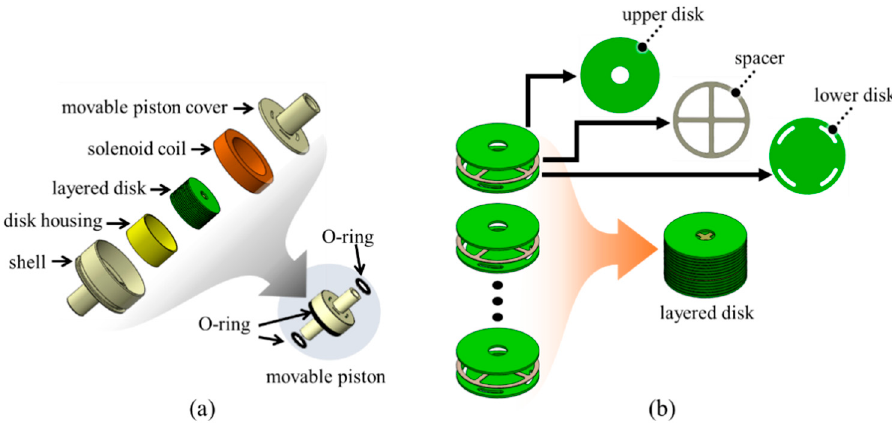
Figure 3. Design of the movable piston: ( a ) Internal structure; ( b ) Schematic illustration of the layered disk.